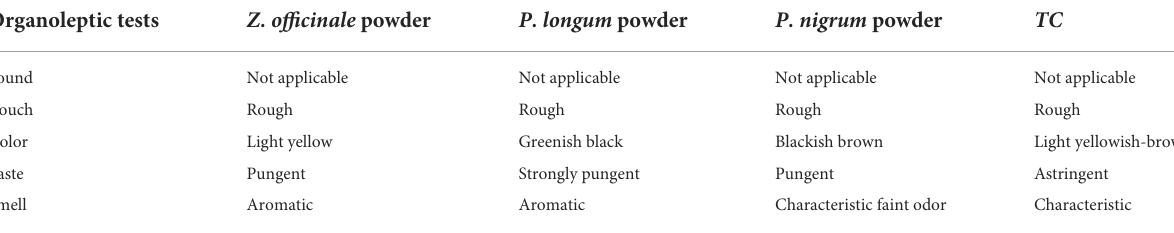
TABLE 3 Organoleptic analysis of prepared herbal powder. Organoleptic tests